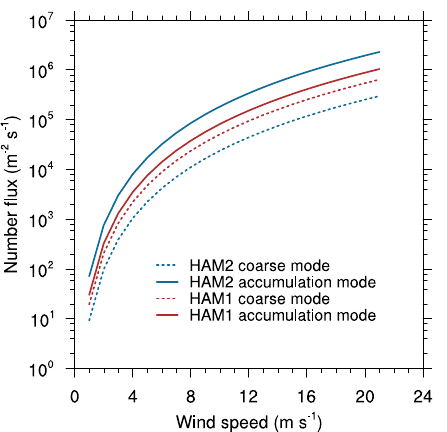
Fig. 5. Accumulation mode and coarse mode sea salt aerosol num- ber fluxes (unit: m − 2 s − 1 ) as functions of 10-m wind speed (unit: m s − 1 ), given by different implementations of the Monahan et al. (1986) and Smith and Harrison (1998) sea salt emission schemes. The red curves correspond to the the old (HAM1) version, and blue the new (HAM2) version.